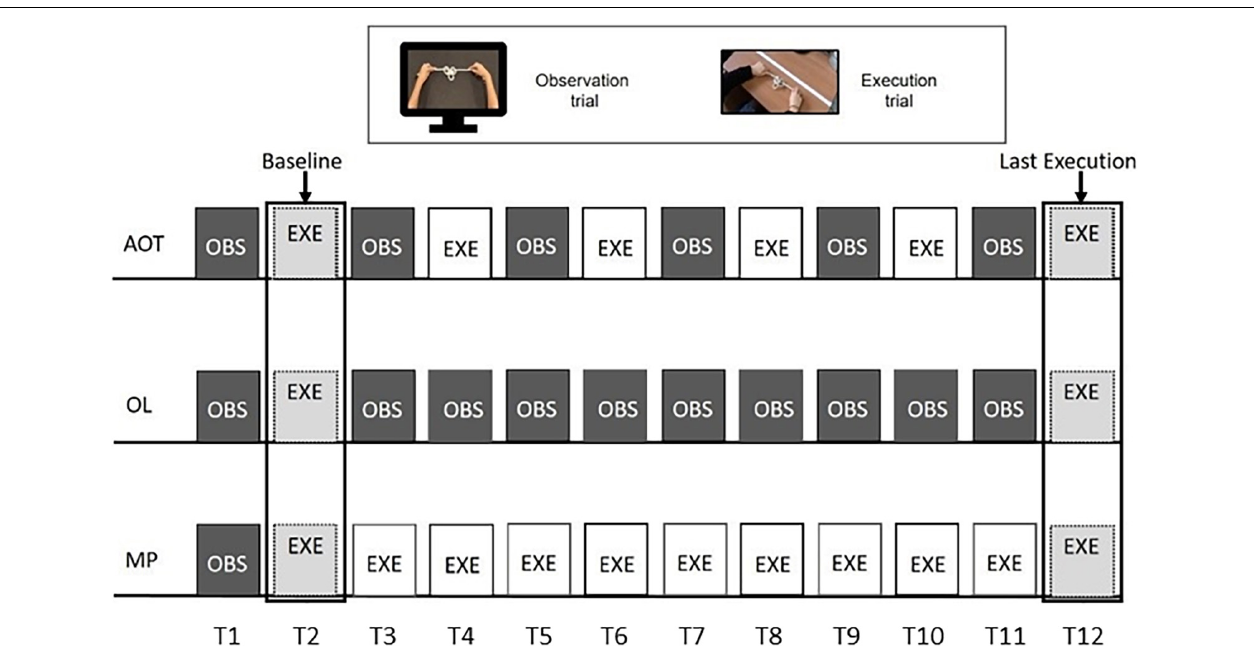
FIGURE 2 | Experimental design. The three rows represent the procedures of action observation training (AOT) (top), observational learning (OL) (middle), and motor practice (MP) (bottom) training. All of them are based on 12 trials, based on action observation (dark gray color) or action execution (white). Light gray indicates the execution trials common to all